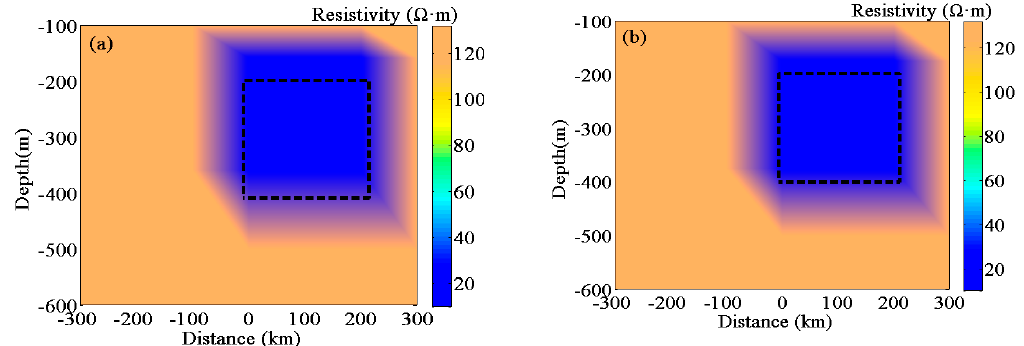
Figure 19. Depth imaging of the 3D polarization model with 50 Hz power frequency noise (( a ) traditional skin depth formula; ( b ) generalized skin depth for polarized porous media) .